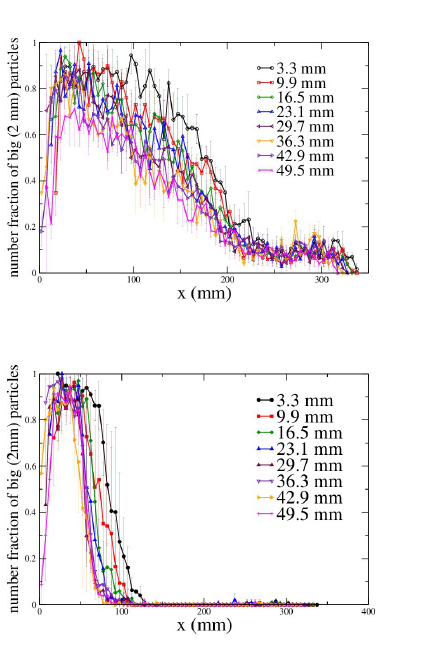
Figure 6. Profiles of number fraction of big particles (2mm) vs component x (mm) with depth y (mm) in layers for mixture of: 25 % (1mm) and 75 % (2mm) & 25 % (2mm) and 75 % (1mm) for top layers (h = 22 cm & volume of pouring 100 g)